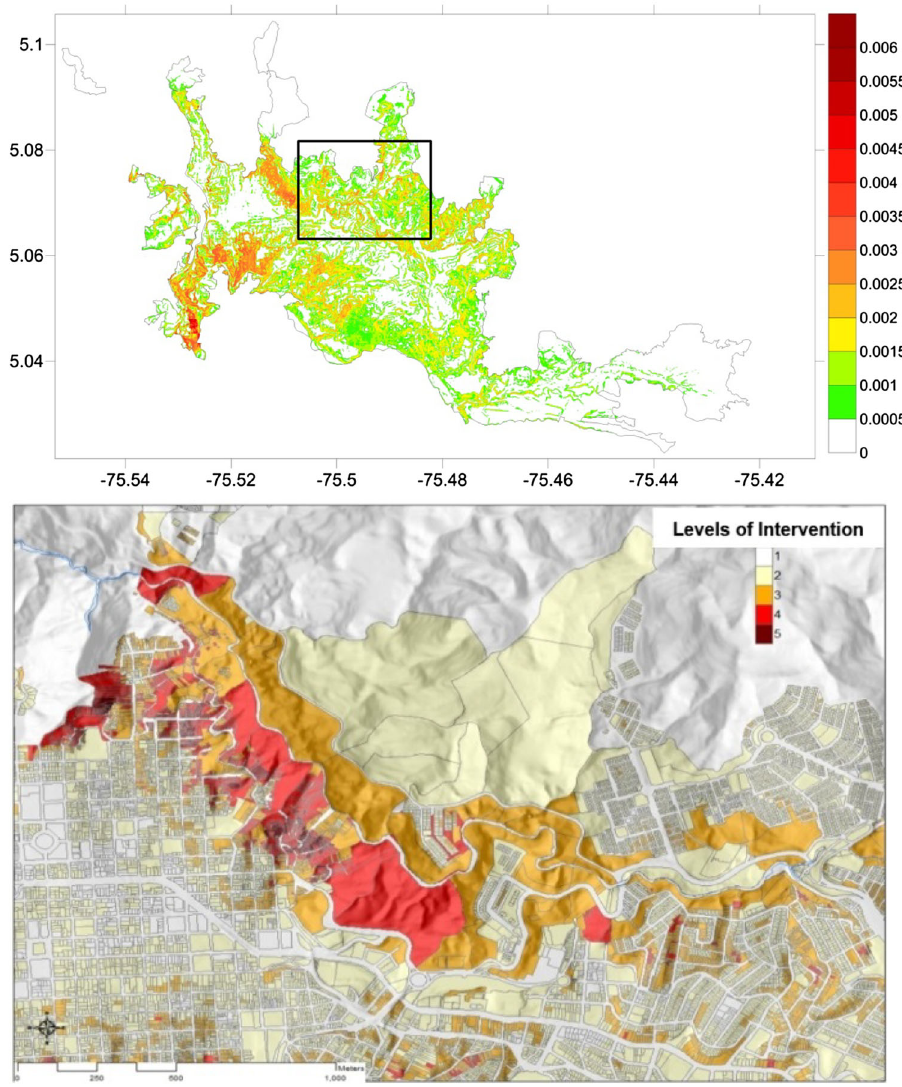
Fig. 2 Top Rain triggered landslide hazard map (annual exceedance rate); Bottom Map of levels of intervention by lots for urban planning of Manizales based on the level of hazard and risk (very low, low, moderate, high, and very high). Source London˜o